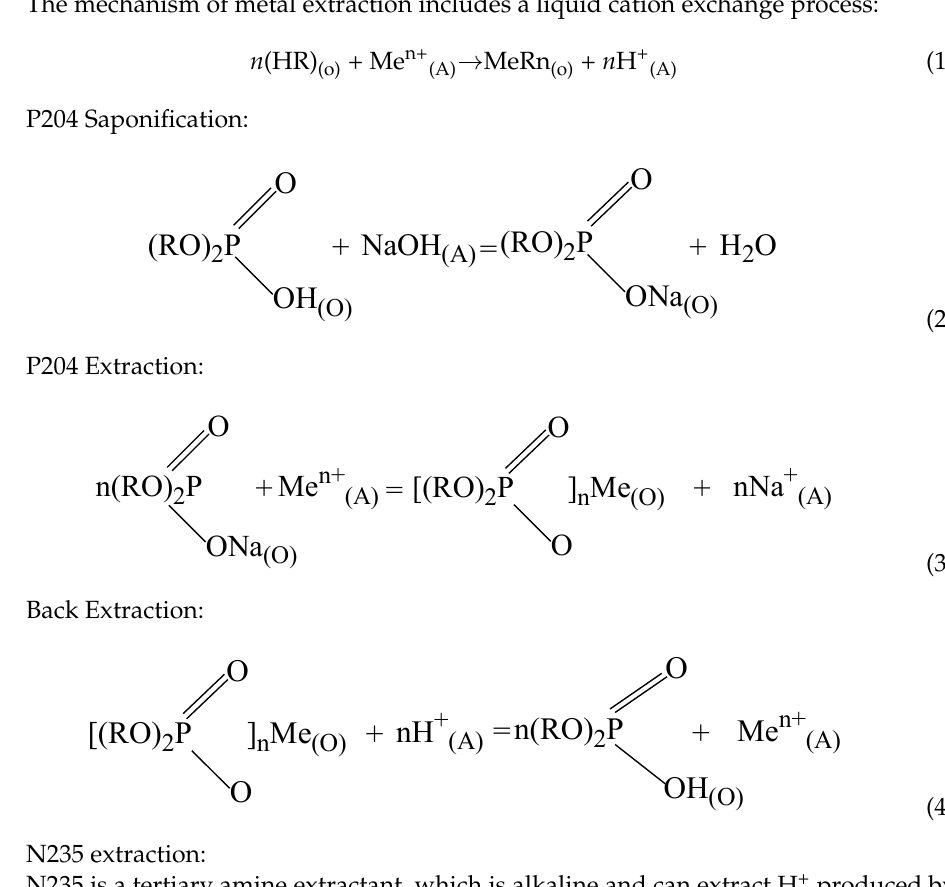
Figure 3. Molecular structure of P204.